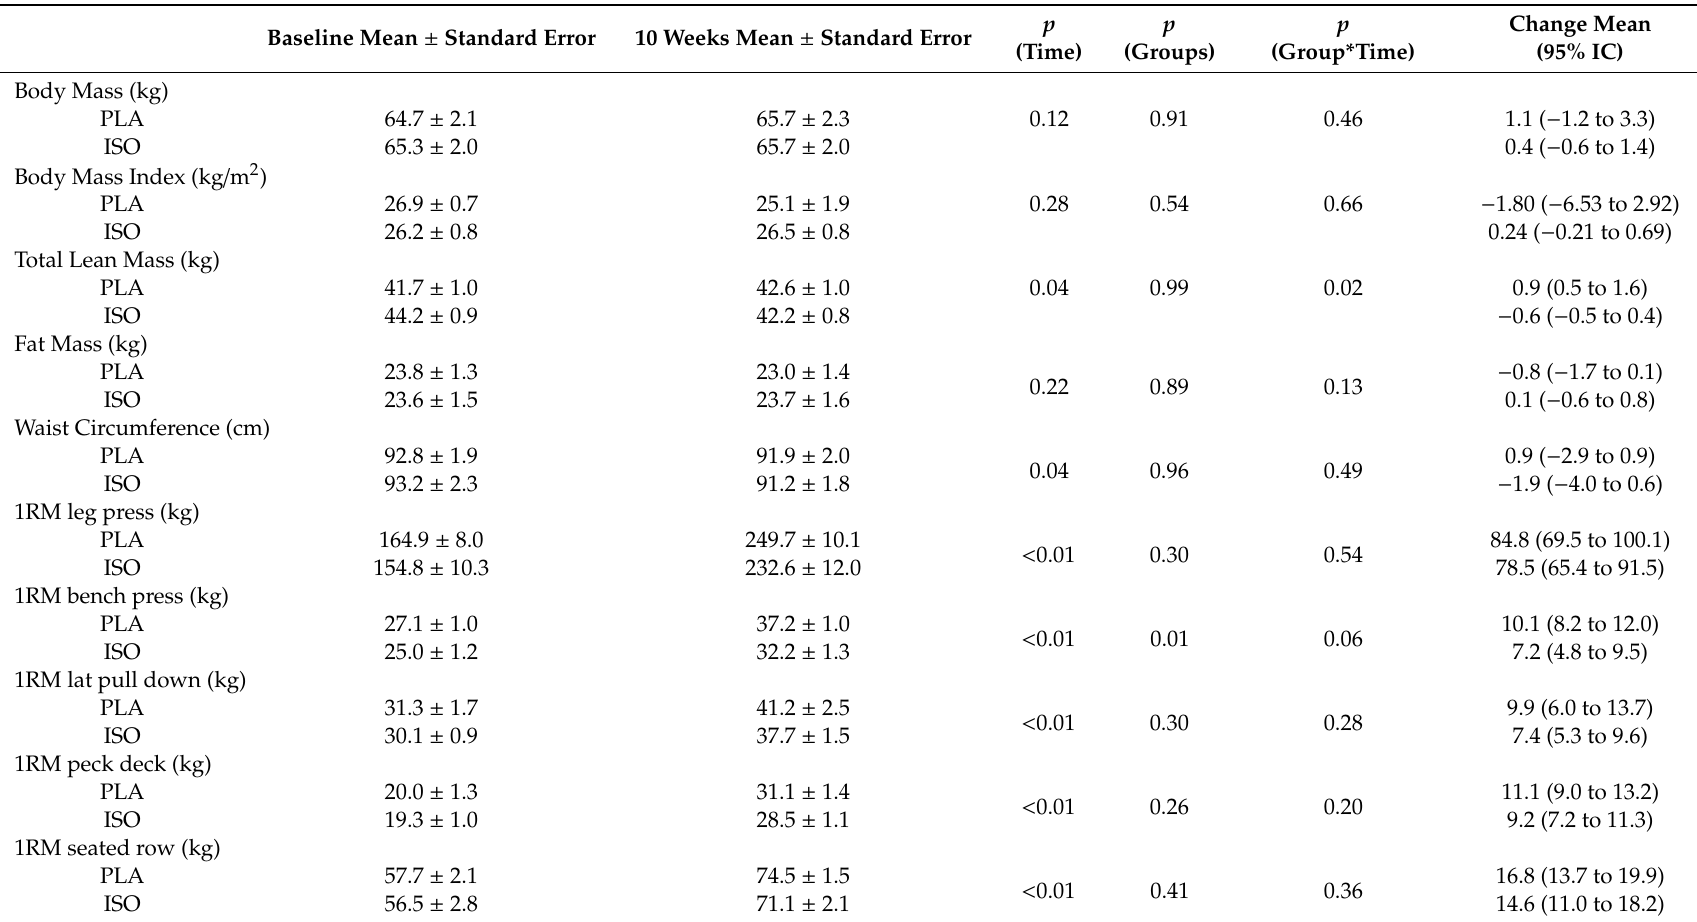
Table 2. Comparison of clinical, anthropometric and strength characteristics at baseline and after 10 weeks combined exercise training moments between groups